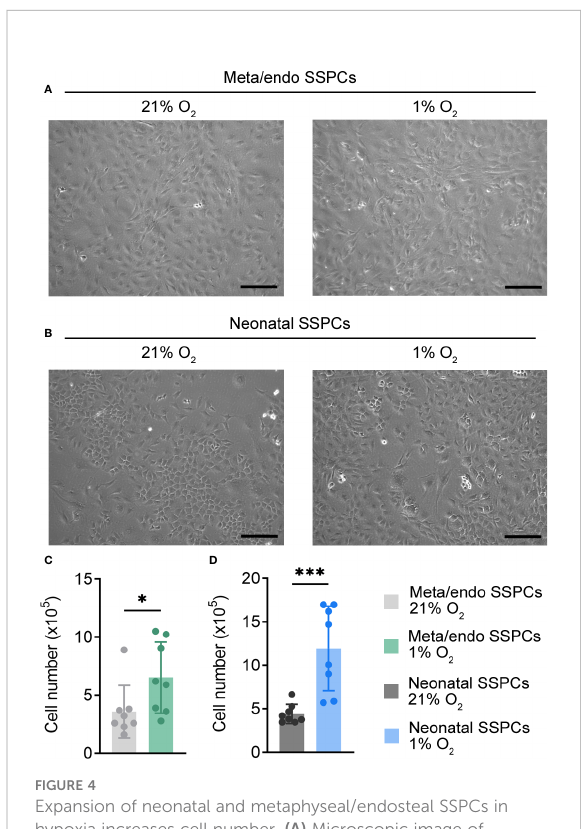
FIGURE 4 Expansion of neonatal and metaphyseal/endosteal SSPCs in hypoxia increases cell number. (A) Microscopic image of metaphyseal/endosteal SSPCs expanded in 21% O 2 and 1% O 2 . Scale bar is 100 µm. Images were taken after one week of culture. (B) Microscopic image of neonatal SSPCs expanded in 21% O 2 and 1% O 2 . Scale bar is 100 µm. Images were taken after one week of culture. (C, D) Absolute cell number of metaphyseal/endosteal (C) and neonatal SSPCs (D) after expansion in 21% or 1% O 2 (n=8). Data are shown as mean ± SD. *p<0.05, ***p<0.001 (Student ’ s t